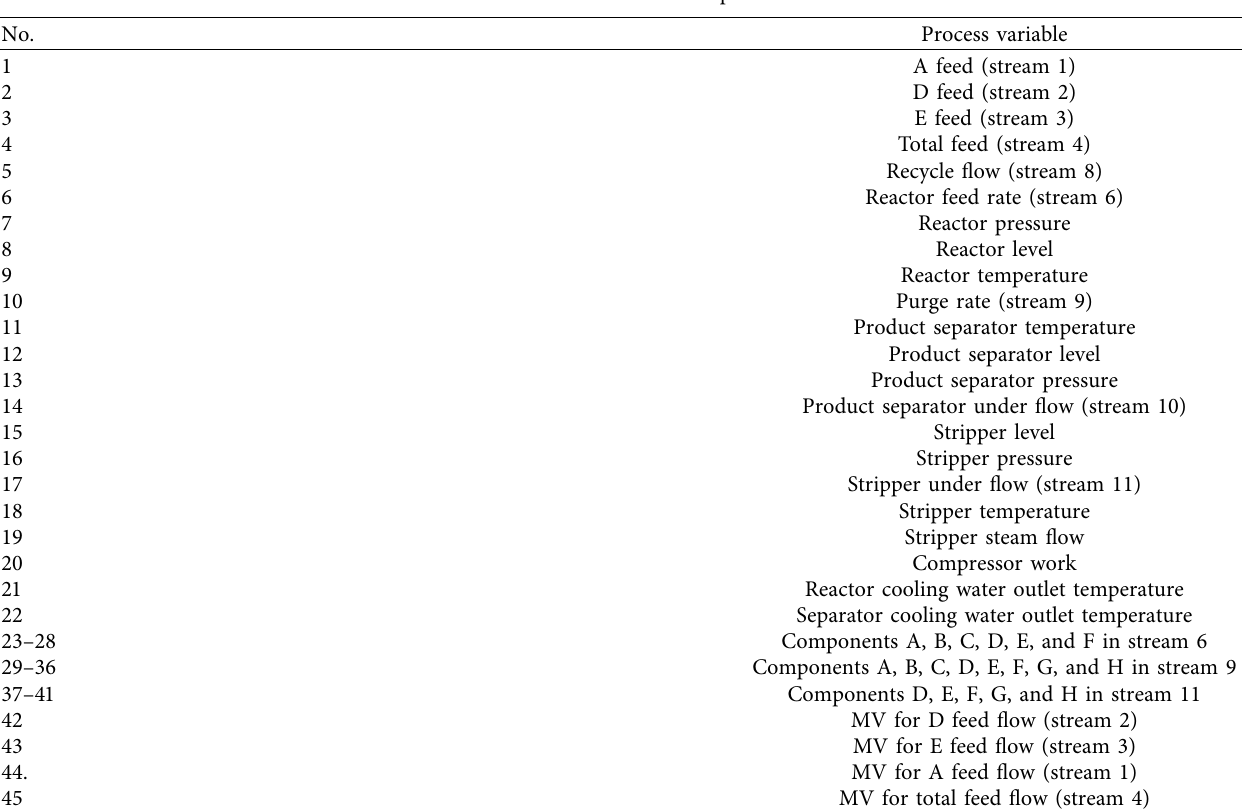
Table 1: Variables of the TE